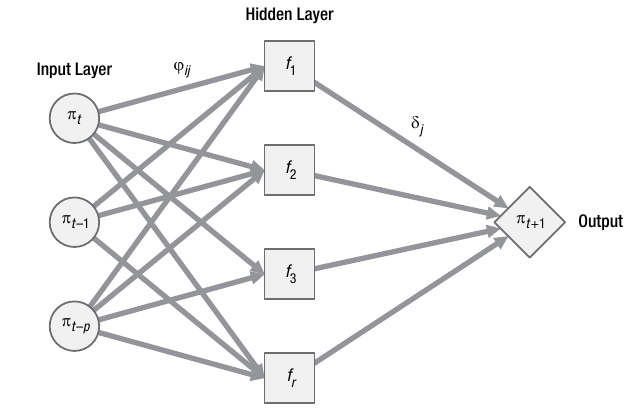
Fig. A2. Feedforward neural network model of